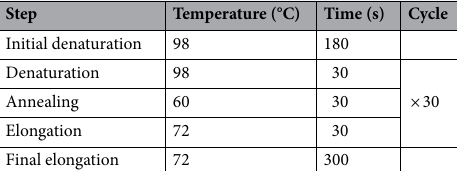
Table 2. PCR program for dsRNA template